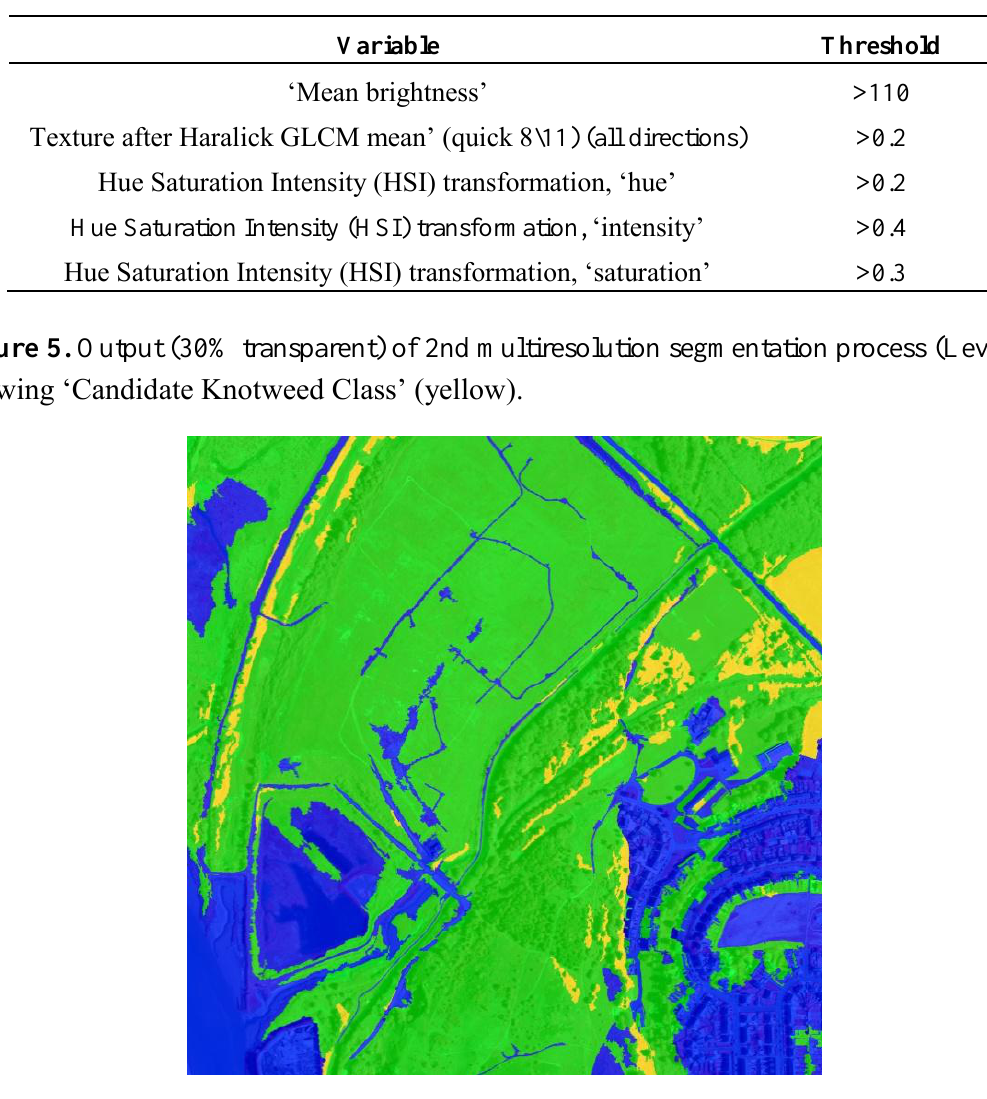
Table 5. ‗Candidate Knotweed‘ Class Description: fuzzy membership thresholds and values.